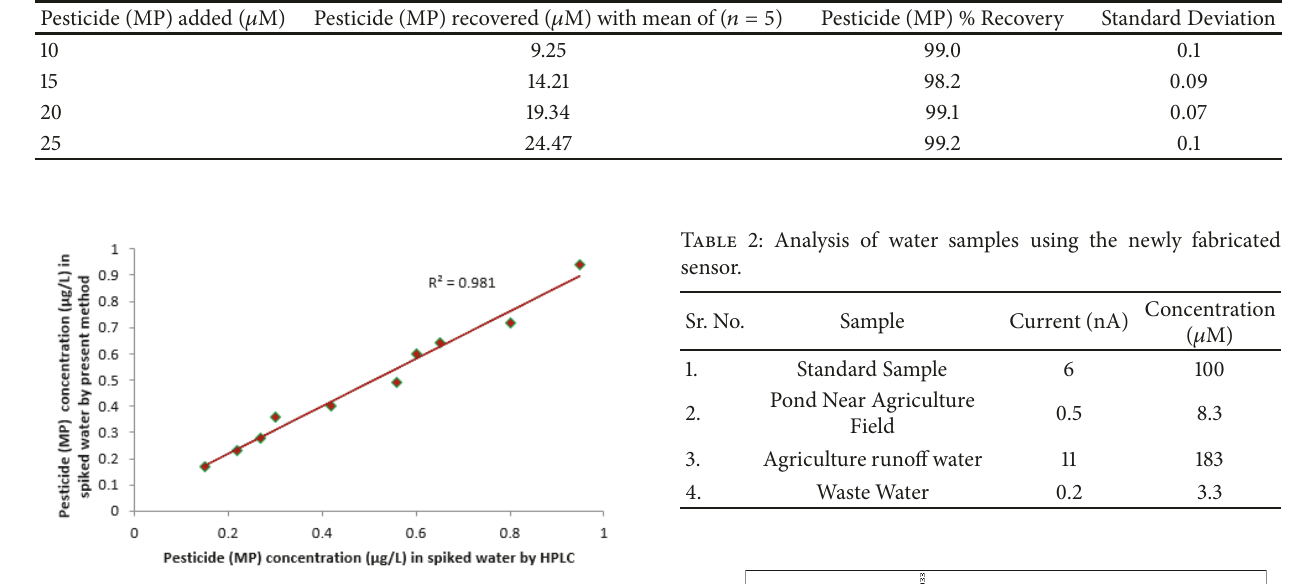
Figure 8: Correlation of standard method HPLC ( 𝑥 ) with the newly developed method ( 𝑦 ).